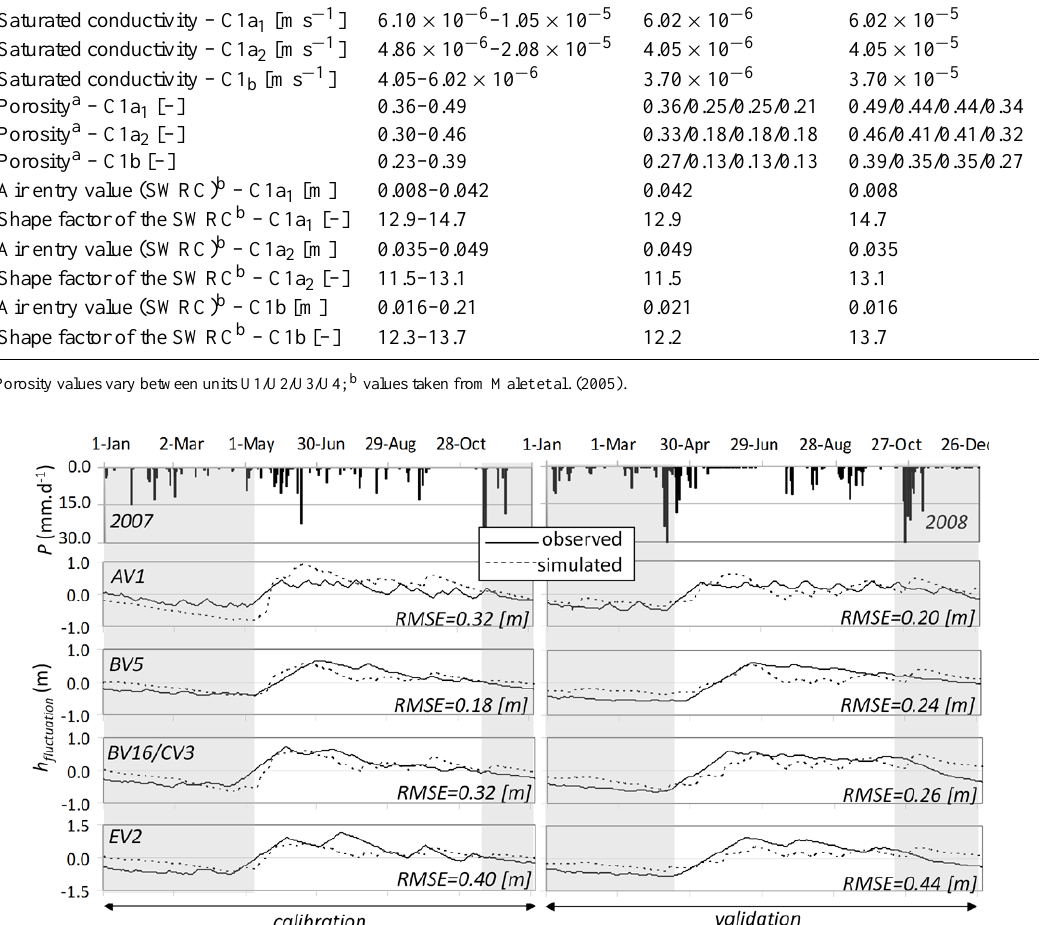
Optimal model parameters